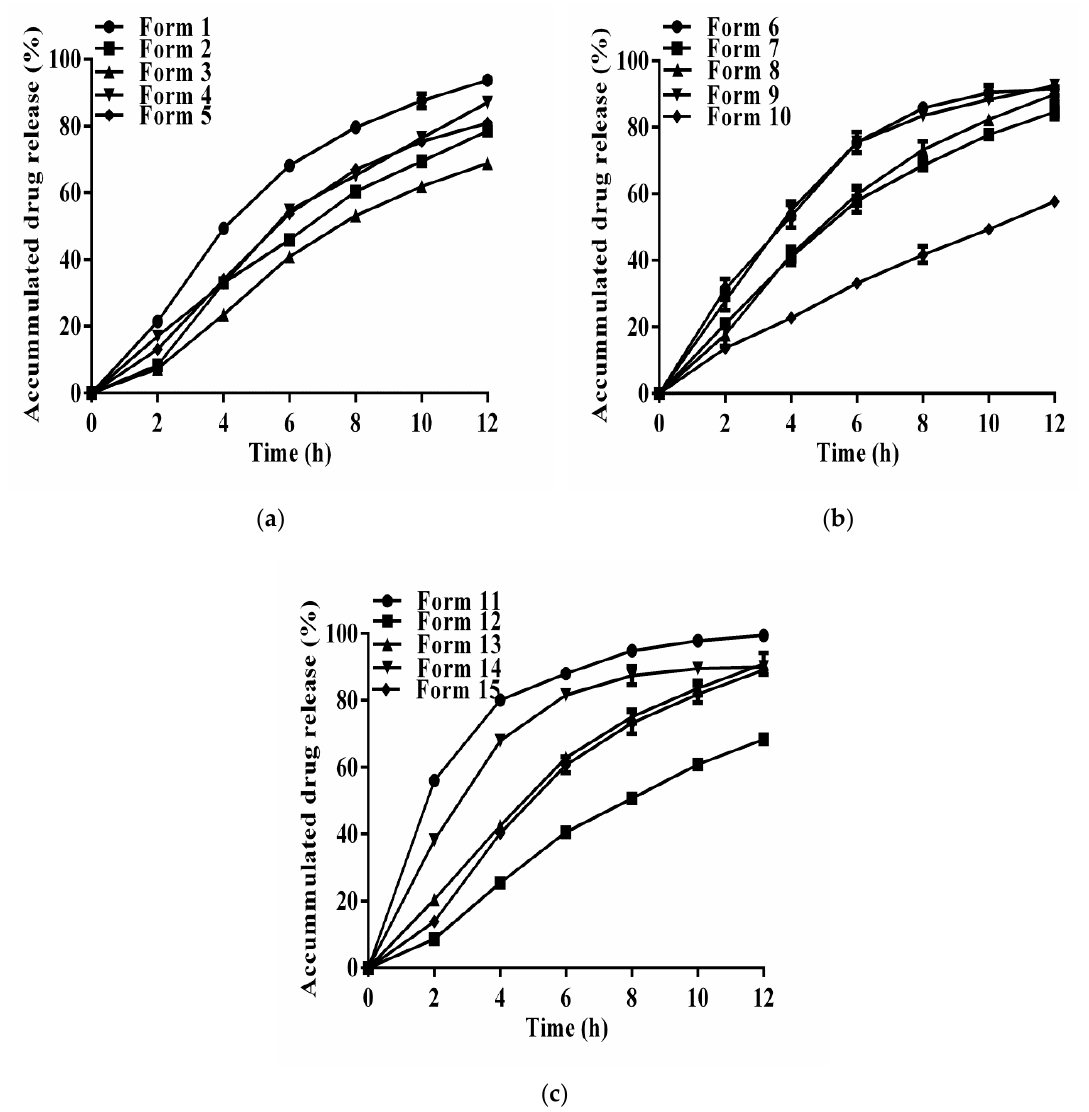
Figure 4. Dissolution profiles of loxoprofen in formulations prepared by the Box-Behnken design experiments ( a ) Formulation Nos. 1–5, ( b ) Formulation Nos. 6–10, ( c ) Formulation Nos. 11–15.